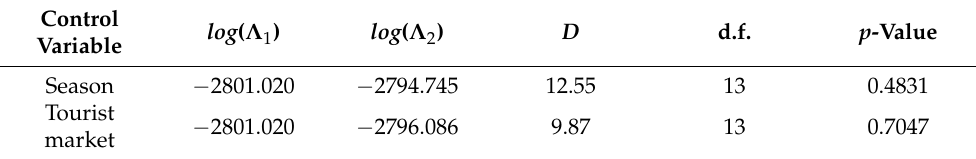
Table 3. Log likelihood ratio test of both control